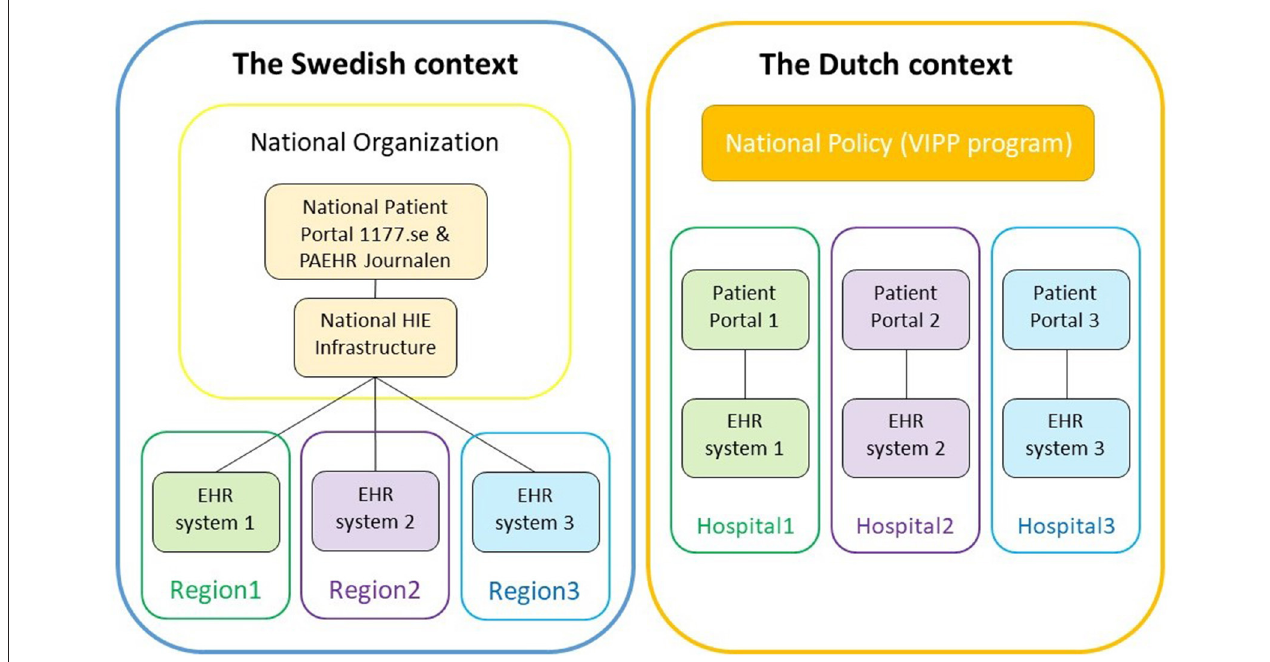
FIGURE 3 | Difference between Sweden’s centralized solution and the Netherlands’